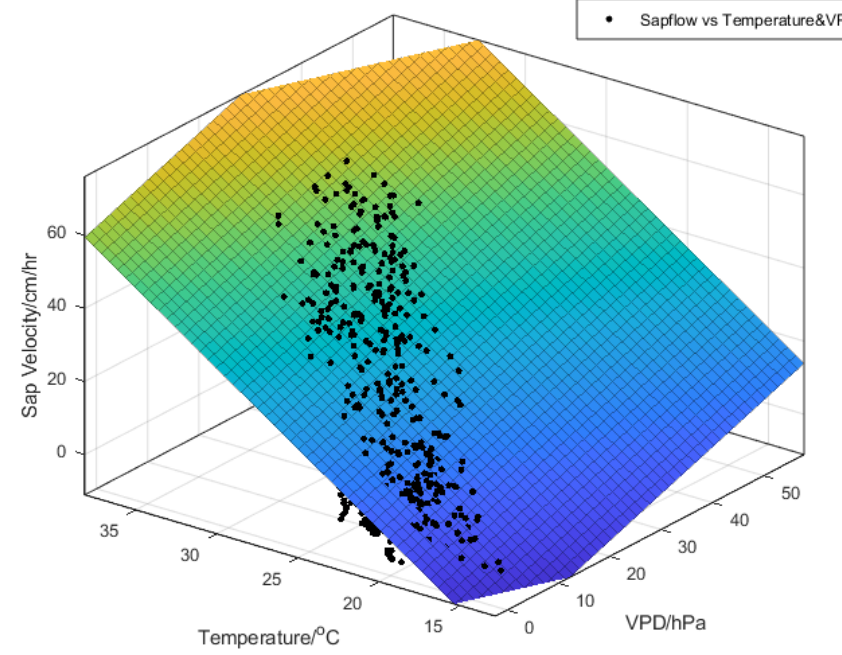
Figure 4. Multilinear regression for sap flow, canopy temperature, and VPD.